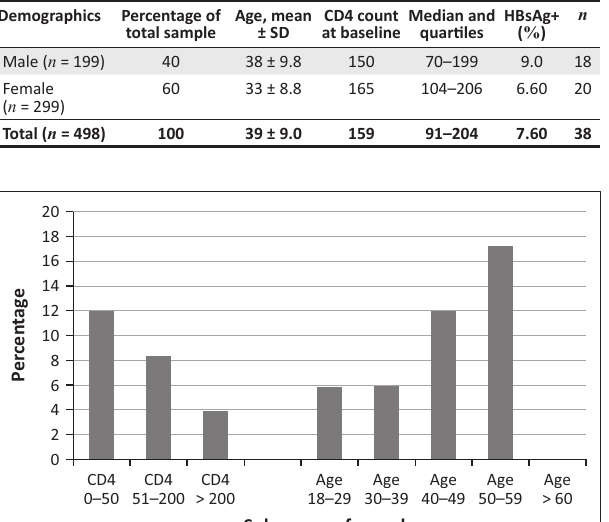
TABLE 1: Demographics and baseline values of the sample.